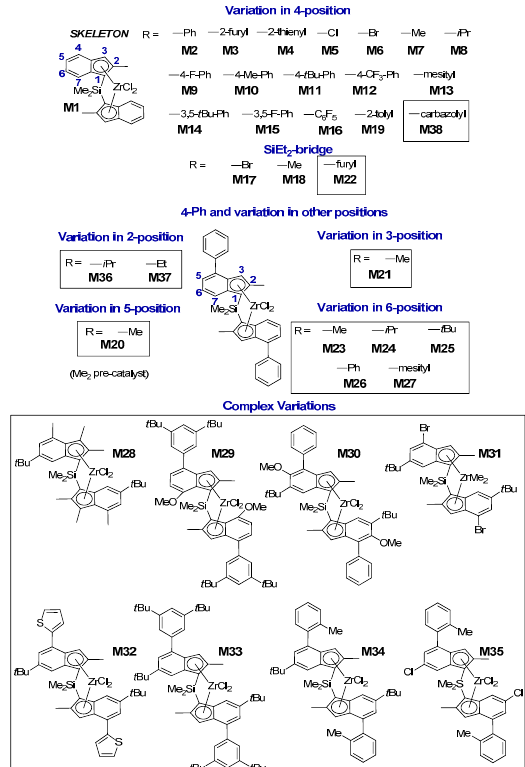
Figure 1. LZrCl 2 precatalysts M1 – M38 synthesized and screened in propene homopolymerization at T p = 60 °C and p (C 3 H 6 ) = 6.6 bar in toluene. The performance of catalysts M1 – M19 which are part of